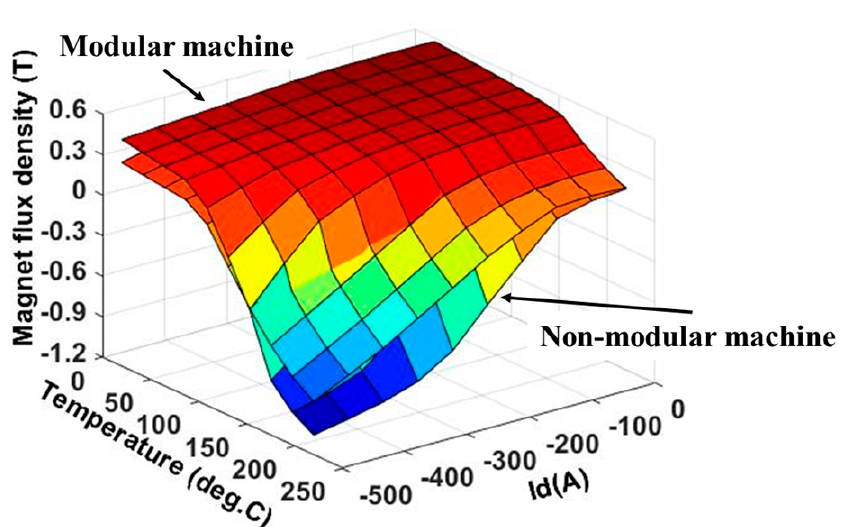
Figure 13. The minimum magnet flux density (radial component) at point A for the investigated machines under different operating conditions.